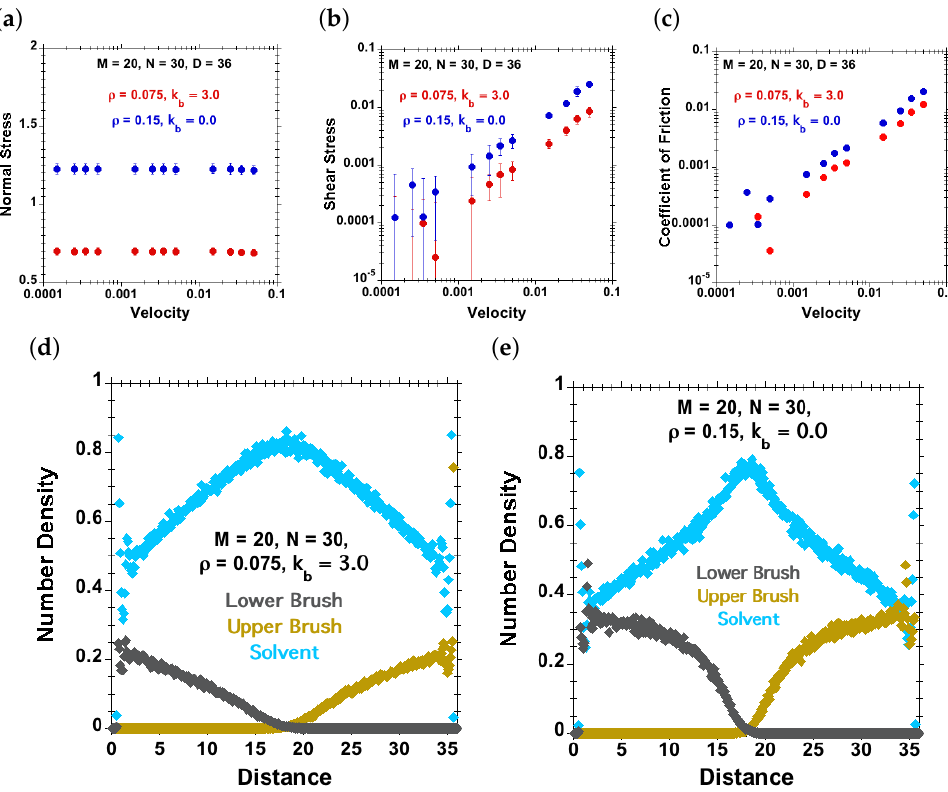
Figure 12. Effect of the combination of chain stiffness and grafting density (red dots for ρ = 0.075, k b = 3 and blue dots for ρ = 0.15, k b = 0) resulting in an equilibrium-brush height h = 18 in each case (remaining identical system parameters: M = 20, N = 30 under good-solvent